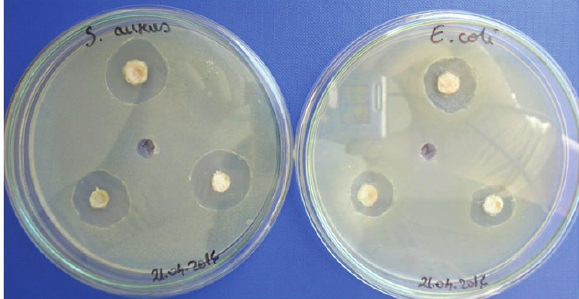
Figure 2: Determination of bacterial sensitivity (A - Staphylococcus aureus , B - Escherichia coli ) in A. cepa liquid extract in wells, at 48 hours of incubation.